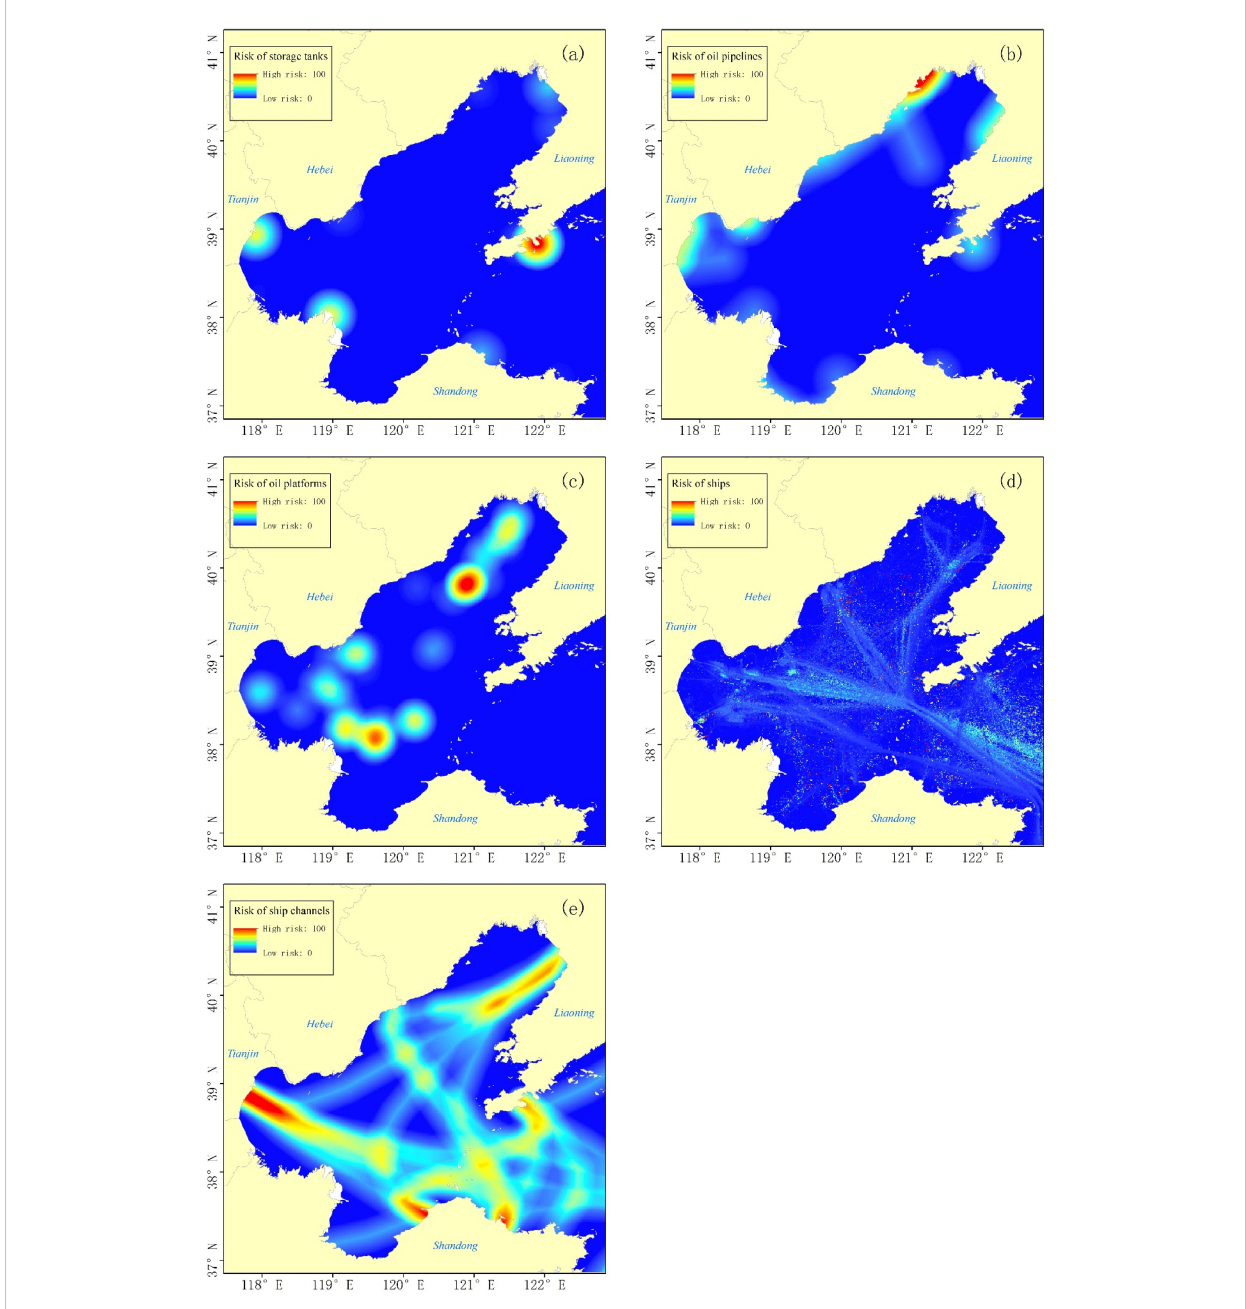
FIGURE 4 Normalized value in terms of each indicator for the Bohai Sea. (A) Risk spatial distribution according to storage tanks. (B) Risk spatial distribution according to oil pipelines. (C) Risk spatial distribution according to oil platforms. (D) Risk spatial distribution according to ships. (E) Risk spatial distribution according to ship